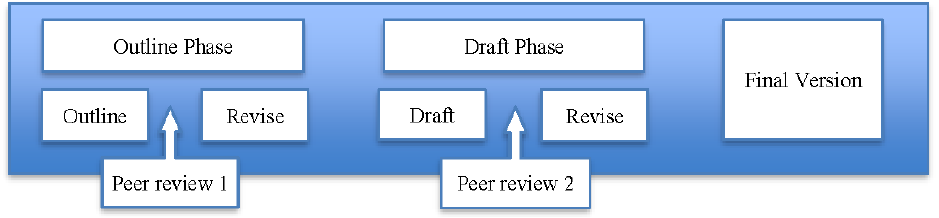
Figure 1. Summary of the L2 writing essay assignment.